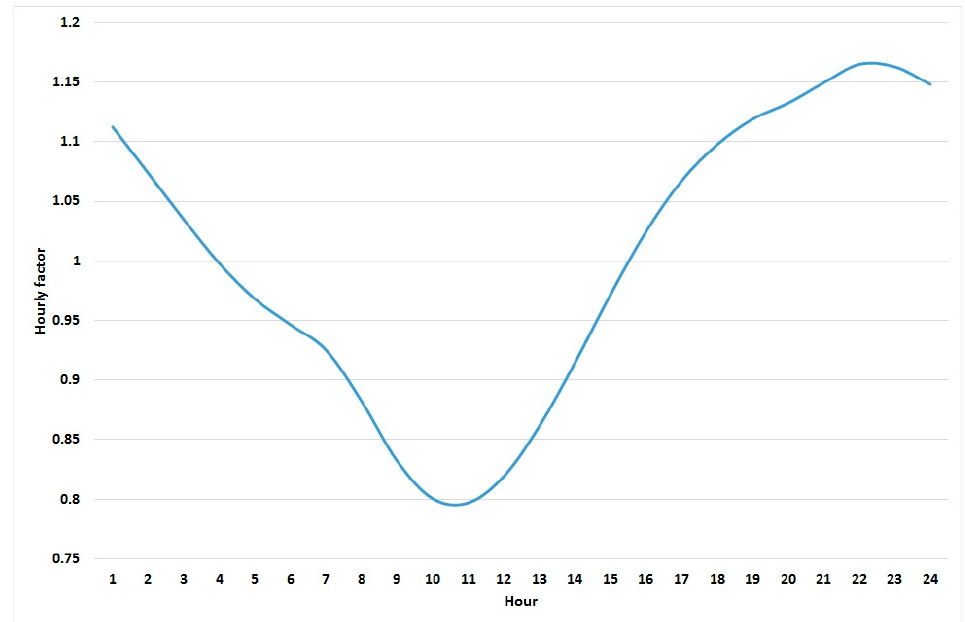
Figure 8. Hourly capacity factor seasonality.